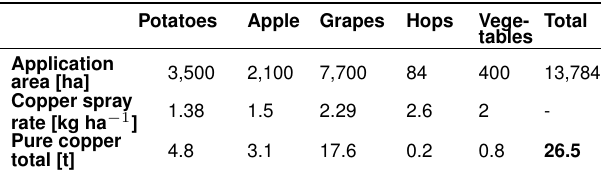
Table 2. Estimated amounts of copper used [pure copper in kg ha − 1 ] in organic farming in Germany in 2013 relative to the application area.